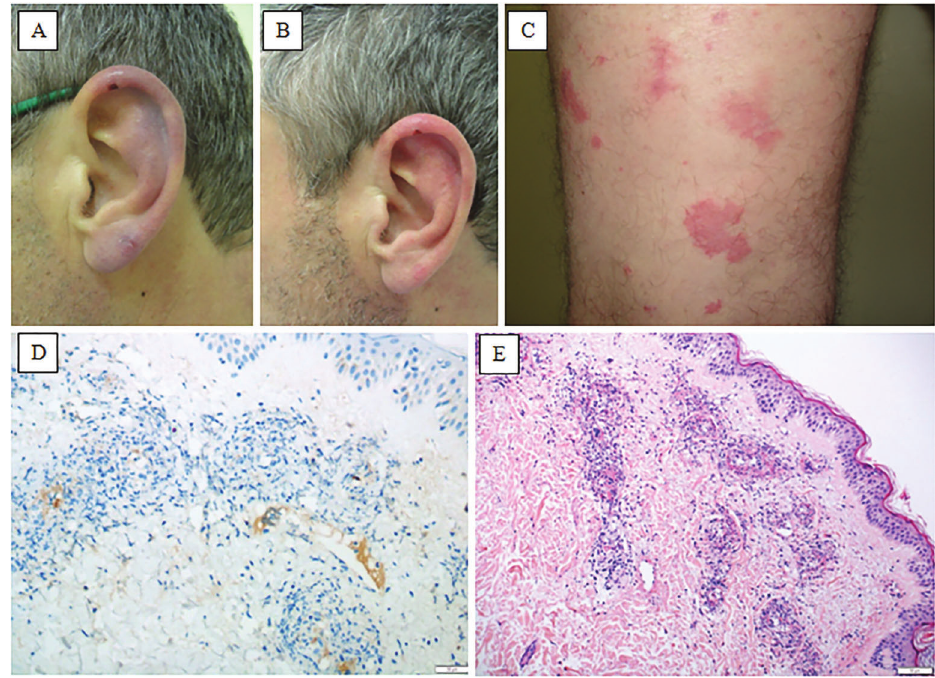
Figure 1. Skin lesions: A , Retiform purpura with a small area of necrosis in the right earlobe (pre-treatment). B , Residual skin lesions in the right earlobe after 3 weeks of immunosuppressive treatment. C , Purpuric violaceous lesions with surrounding erythema in the lower limb. Skin biopsy: D , Immunohistochemistry with anti-CD61 antibody showing positive staining for thrombi inside the vascular lumen, with surrounding in fl ammation of the vessel wall (magni fi cation 100 (cid:1) ). E , Small vessel vasculitis with neutrophilic in fl ammation and leukocytoclasia (H&E, magni fi cation 100 (cid:1)